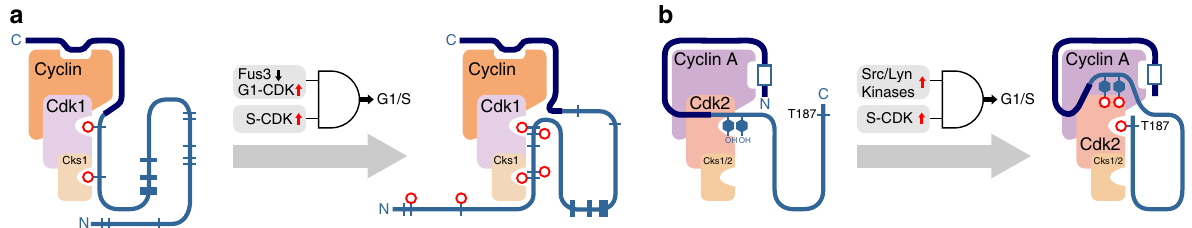
Fig. 7 Regulation of mammalian p27 and yeast Sic1 is functionally analogous. a , b The intracomplex phosphorylation and subsequent release of CDK activity is regulated by AND gate-like logic. a In case of yeast Sic1, the increase of proliferation signal G1-CDK, and decrease of mating signal Fus3 prime Sic1 for inhibited S-CDK, which executes the Sic1 degradation and triggers the S-phase. b Analogously, in case of mammalian p27, the tyrosine kinases as proliferation signals prime the intracomplex phosphorylation for inhibited S-phase CDK